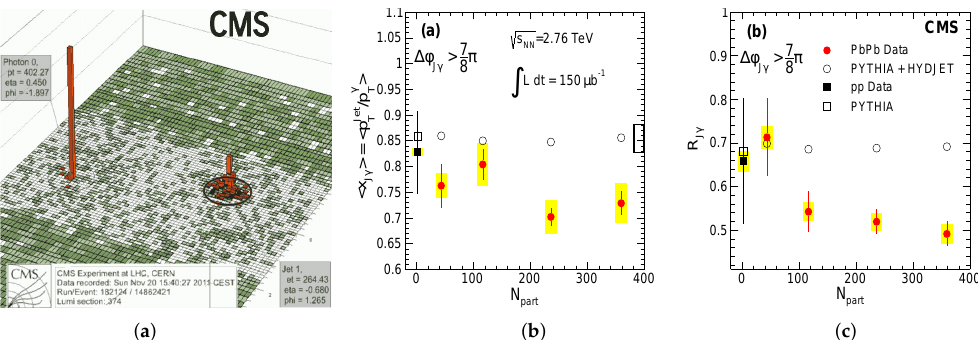
Figure 24. ( a ): The energy distribution in the η × φ plane in a single Pb + Pb event recorder by the CMS detector at LHC (reproduced from Ref. [336]); ( b ) and ( c ): The average ratio of jet transverse momentum (cid:10) (cid:11) x J γ to photon transverse momentum and the average fraction R J γ of isolated photons with an associated jet with energy above 30 GeV as functions of number of participants N part . Photons and jets are emitted almost back-to-back in azimuth φ J γ . Reproduced from Ref.